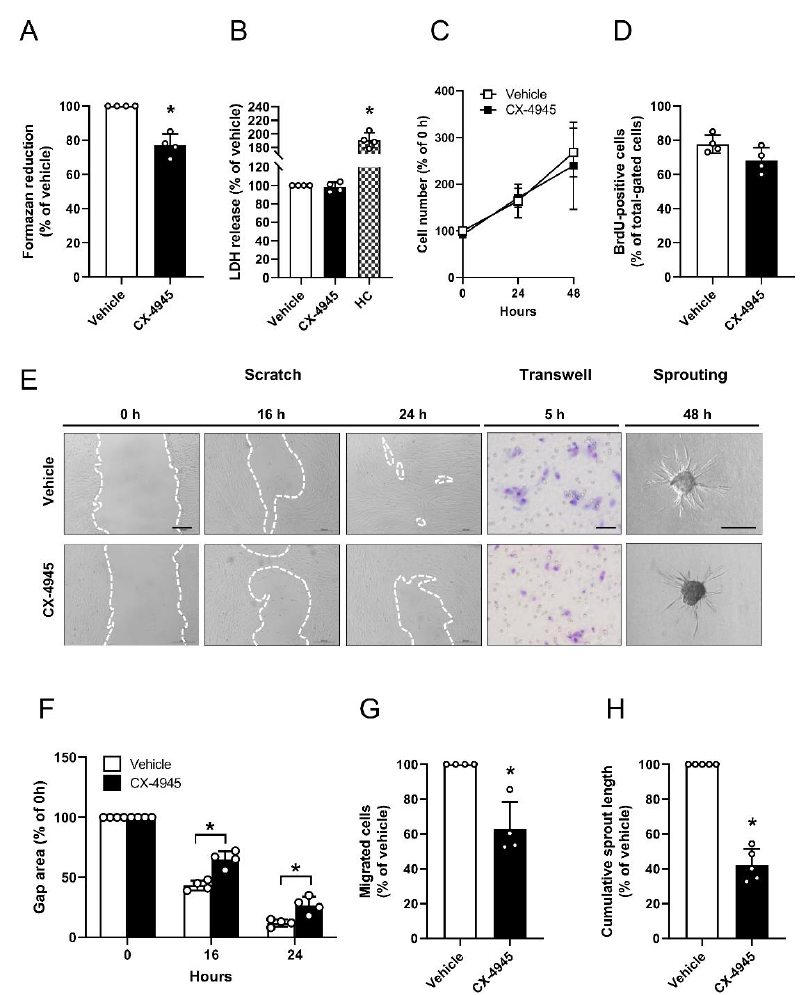
Figure 3. E ff ect of CK2 inhibition on proliferation, migration and sprouting of pericytes. ( A ) Pericytes were treated with vehicle (DMSO) or CX-4945 (10 µ M) for 48 h and the mitochondrial activity was analyzed by a WST-1 assay. Vehicle-treated cells were set 100%. Mean ± SD. * p < 0.05 versus vehicle ( n = 4). ( B ) Pericytes were treated as described in ( A ) and the cytotoxicity was assessed by a LDH assay. Vehicle-treated cells were used as control and set 100% ( n = 4). Cells were permeabilized with Triton-X100 (0.1%) and used as high toxicity control (HC) for the LDH assay. Mean ± SD. * p < 0.05 versus vehicle ( n = 4). ( C ) Pericytes were cultured for 24 h and thereafter treated with vehicle (DMSO) or CX-4945 (10 µ M). The cell number was determined 0, 24 and 48 h after the onset of treatment. Vehicle-treated pericytes (0 h) were set 100% ( n = 3). Mean ± SD. ( D ) Pericytes were treated as described in ( A ) and the MFI of BrdU-positive cells (% of total gated cells) was assessed by flow cytometry ( n = 4). Mean ± SD. ( E ) Pericytes were pretreated for 48 h with vehicle (DMSO) or CX-4945 (10 µ M) and analyzed by scratch assays (scale bar: 200 µ m) and transwell migration assays (scale bar: 50 µ m) at the indicated time points. For sprouting assays, spheroids were treated with vehicle (DMSO) or CX-4945 (10 µ M) for 48 h and cumulative sprout length was analyzed (scale bar: 200 µ m). ( F ) Quantitative analysis of gap area after 0, 16 and 24 h (scratch assay). The gap area at 0 h was set 100%. Mean ± SD. * p < 0.05 versus vehicle ( n = 4). ( G ) Quantitative analysis of migrated cells after 5 h (transwell migration assay). Vehicle-treated cells were set as 100%. Mean ± SD. * p < 0.05 versus vehicle ( n = 4). (H) Quantitative analysis of cumulative sprout length after 48 h (spheroid sprouting assay). The cumulative sprout length of vehicle-treated spheroids was set as 100%. Mean ± SD. * p < 0.05 versus vehicle ( n =